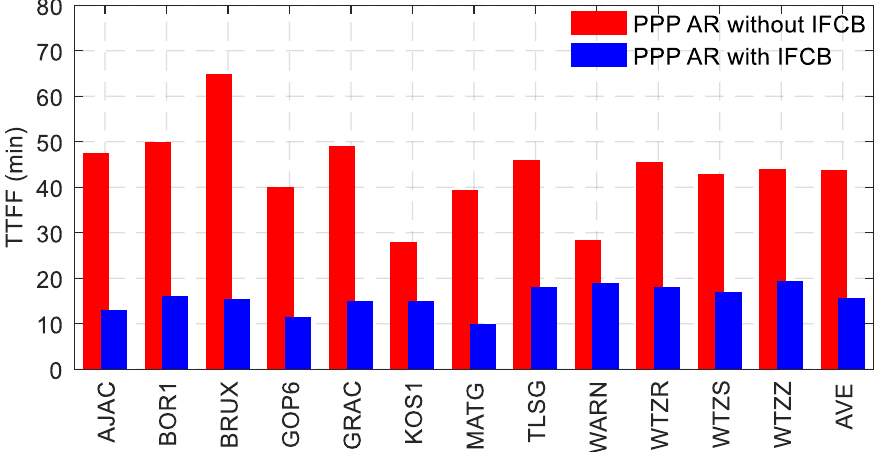
Figure 7. TTFF of static UDUC-PPP AR with or without observable-specific IFCB corrections at twelve different user stations.